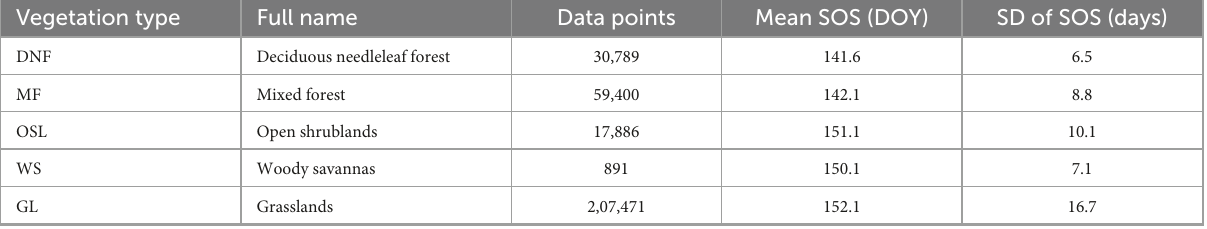
TABLE 1 Statistics of spring phenology of five vegetation types in the study area (1982–2014) on the day of year (DOY): (a) deciduous needleleaf forest (DNF), (b) mixed forest (MF), (c) open shrublands (OSL), (d) woody savannas (WS), and (e) grasslands (GL). Vegetation